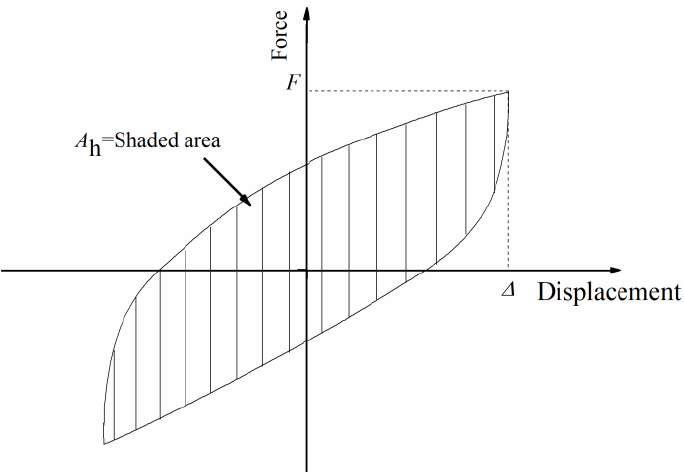
Figure 15. Hysteretic area for damping calculation.